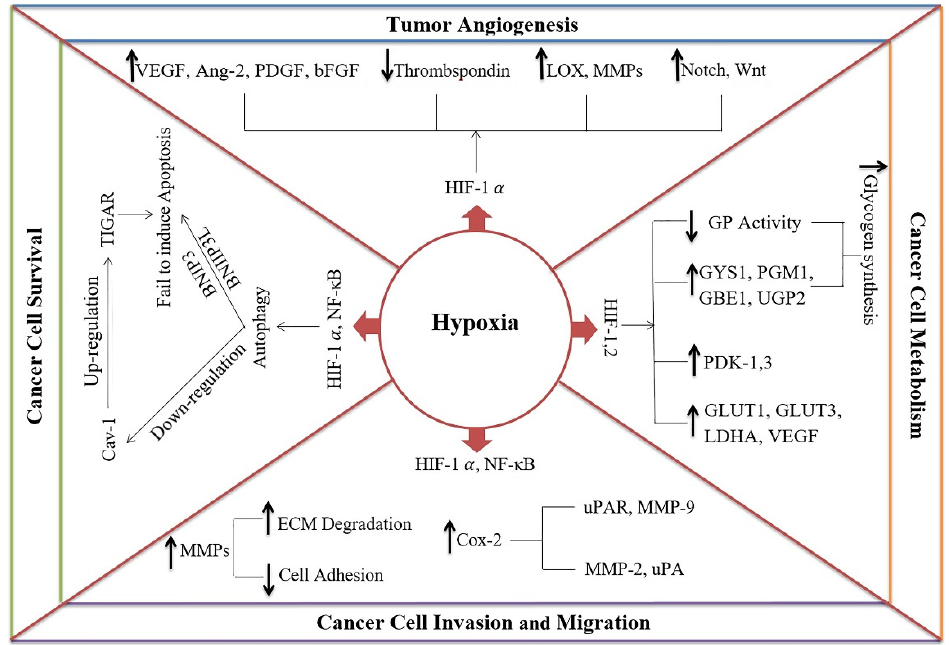
Figure 1. The mechanisms of hypoxia in cancer progression. Hypoxia enhances cancer cell survival by inducing autophagy via hypoxia-inducible factor-1 alpha (HIF-1 α ) and nuclear factor kappa-light-chain-enhancer of activated B cells (NF- κ B). Subsequently, it causes (1) the down-regulation of caveolin-1 (Cav-1), leading to the up-regulation of TP53-inducible glycolysis and apoptosis regulator (TIGAR) and protects cells against oxidative stress and apoptosis, and (2) protection of the cells from apoptosis via BCL2 interacting protein 3 (BNIP3) and BCL2 interacting protein 3-like (BNIP3L). Hypoxia can induce tumor angiogenesis by (1) increasing proangiogenic factors such as vascular endothelial growth factor (VEGF), angiopoietin-2 (Ang-2), platelet-derived growth factor (PDGF), and basic fibroblast growth factor (bFGF), (2) decreasing angiogenesis inhibitors such as thrombospondin, (3) up-regulation of extracellular matrix (ECM) proteins, such as lysyl oxidase (LOX) and matrix metalloproteinases (MMPs), and (4) activating Notch and Wnt signaling pathways. Hypoxia increases cancer cell invasion and migration by the down-regulation of cell adhesion molecules and the up-regulation of ECM degradation molecules such as MMP-9 and urokinase-type plasminogen activator receptor (uPAR). Hypoxia affects the metabolic pathways to provide high energy for cancer cells by (1) enhancing the transcription of glucose transporters genes (GLUT1 and GLUT3), VEGF, and glycolytic enzymes (e.g., lactate dehydrogenase, LDHA), (2) inducing the expression of glycogenesis enzymes including phosphoglucomutase-1 (PGM1), glycogen synthase-1 (GYS1), UDP-glucose pyrophosphorylase 2 (UGP2) and 1,4-alpha-glucan branching enzyme 1 (GBE1), (3) reducing glycogen phosphorylase (GP) activity, and (4) diverting pyruvate from the citric acid cycle into lactate by pyruvate dehydrogenase kinases-1 and -3 (PDK-1 and -3).